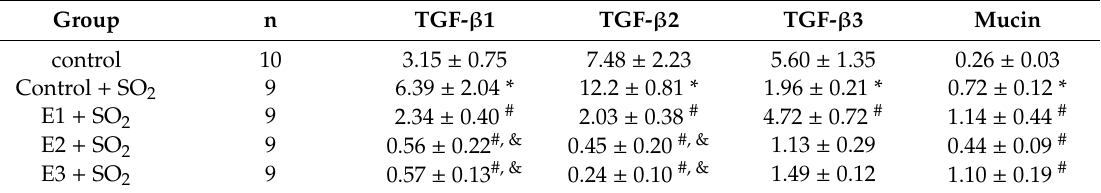
Table 5. Influence of di ff erent extracts from Platycodon grandiflorum A. DC on TGF- β 1, TGF- β 2, TGF- β 3, and mucin (MUC5AC) mRNA expression in the rats’